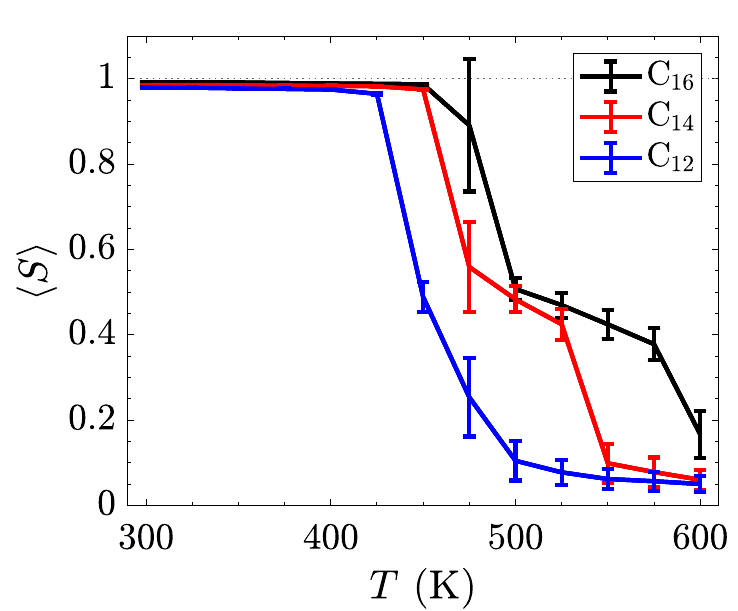
Figure 6. Nematic order parameter as a function of temperature for three different alkyl chain lengths, averaged over the last 200ns of the trajectory. The layers are calculated separately and averaged, due to the opposite tilting directions in the crystal phase. Two distinct phase transitions can be observed as discontinuous jumps in this order parameter. The error bars are larger on temperatures near transition points, as the systems fluctuate more there, thus introducing more variance into trajectory-averaged